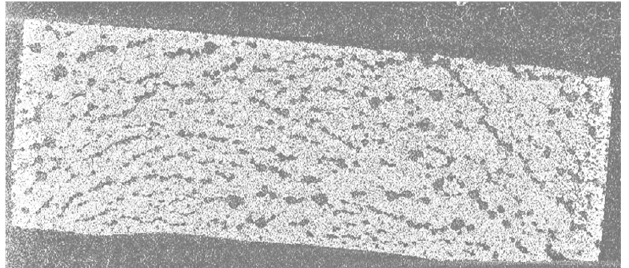
Figure 4. Tomography (internal diameter cut view, diameter = 10 mm) of the sample consolidated by FIP showing an uniform distribution of pores by increasing the content of solvent.